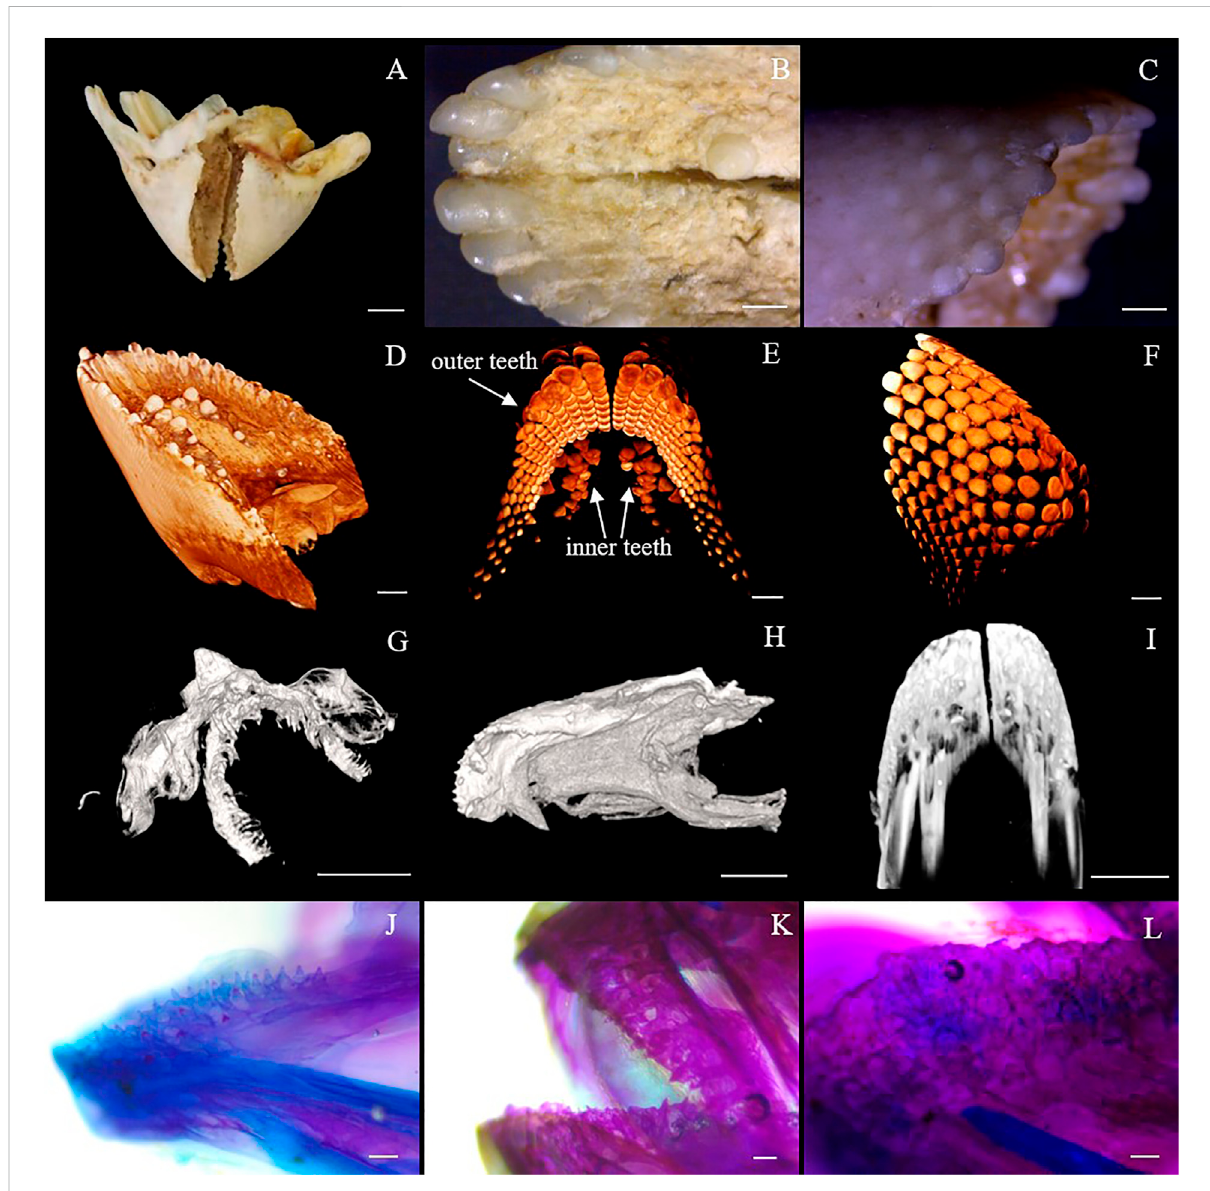
FIGURE 1 Beak-like tooth morphology of Oplegnathus . (A) Photographs of the overall morphology of the beak-like teeth of Oplegnathus . (B) Enlarged image of locoregional details of the inner teeth of Oplegnathus . (C) Enlarged image of locoregional details of the outer teeth of Oplegnathus . (D – F) Reconstructedmicro-CTscansshowingthenesteddentitionofadult Oplegnathus . (E) Three-dimensionalarrangementoftheinnerandouterteeth of Oplegnathus. (G – I) Micro-CTscans showingthedevelopmental changesofthenested dentitionof Oplegnathus at30,50and 70 dph. (J – L) Alizarin red staining results of beak-like teethin different developmental stages of Oplegnathus . (J) indicates that the 45-dph beak-like teethare ina cartilaginous state and separately arranged, (K) indicates that the 50-dph beak-like teeth are ossi fi ed and have a tendency to heal, and (L) indicates thatcompletehealingofthebeak-liketeethhasoccurredby90 dph(scalebars:5 mmin (A) ;1 mmin (B,C,I) ;2 mmin (D,F) ;500 μ min (G,H) ;100 μ m in F and H; and 100 μ m in (J – L)